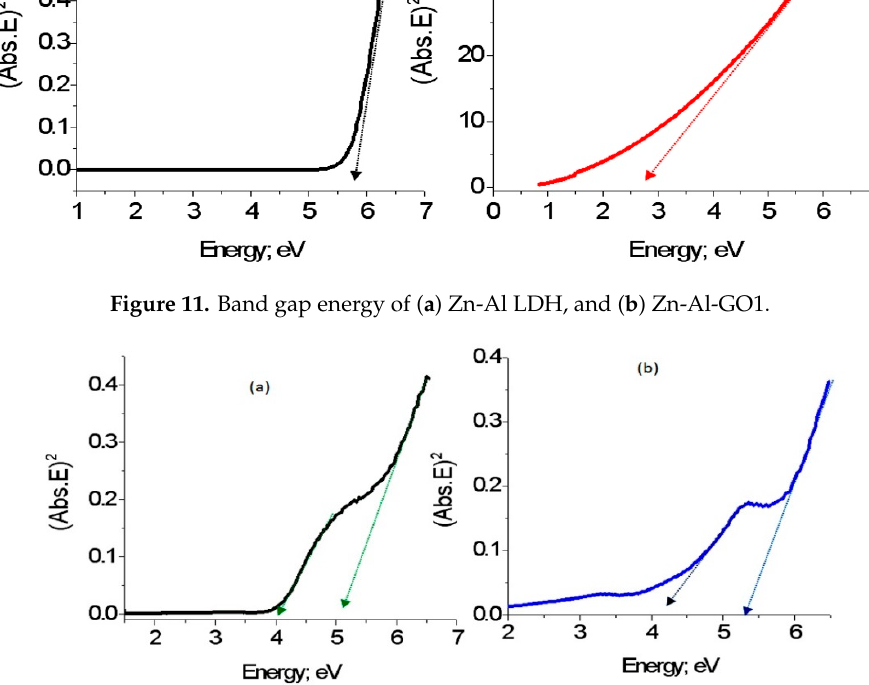
Figure 12. Band gap energy of ( a ) Zn-Al-GO2, and ( b ) Zn-Al-GO3.